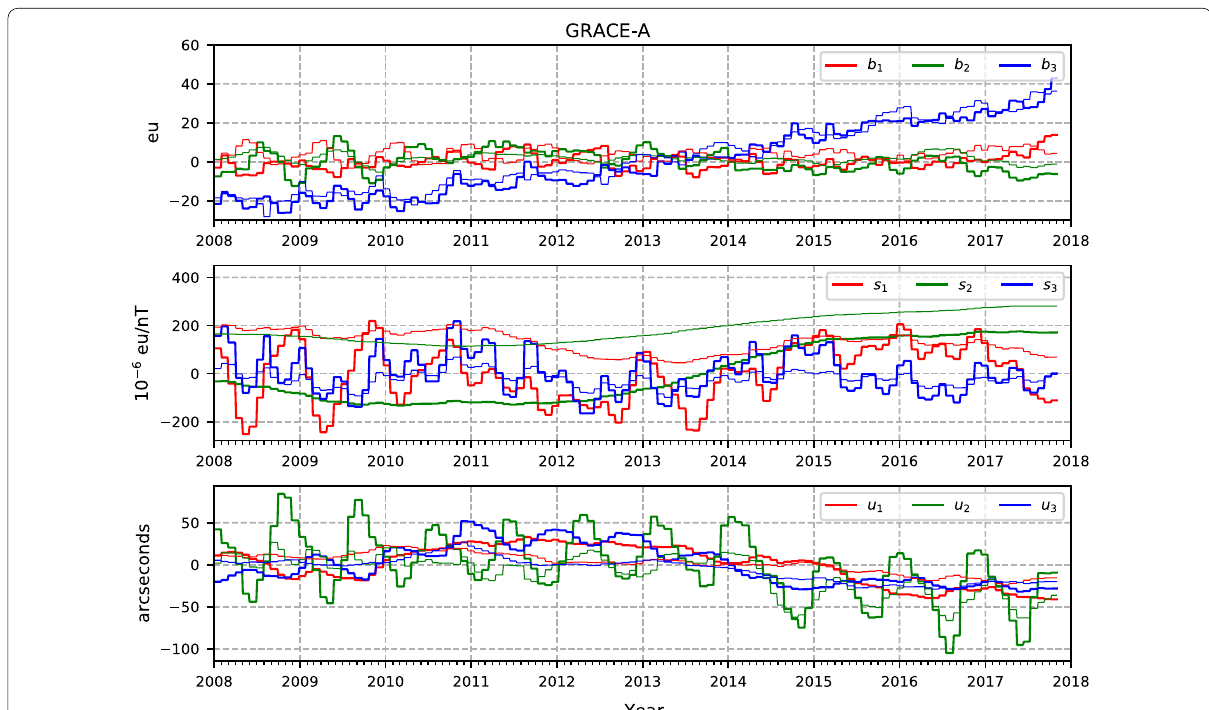
Fig. 8 Calibration parameters of GRACE-A computed with Model-B (thick lines) and Model-E (thin lines). We removed the mean values from the calibration parameters as given in Table